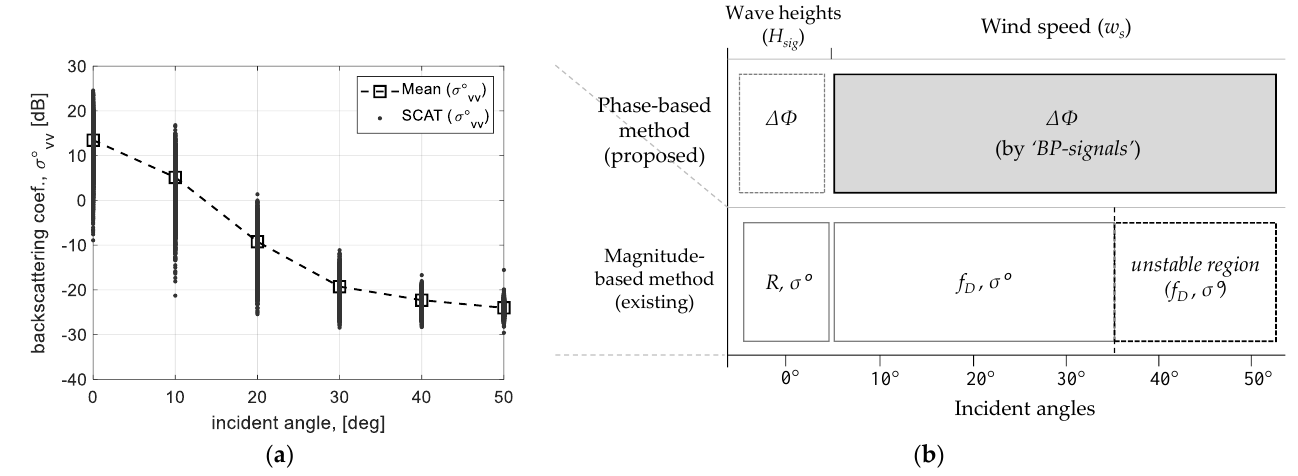
Figure 2. Radiometric angular responses from the sea surface and available range of radar measure- ment parameters: ( a ) backscattering coefficients ( σ ° vv ) measured by self-manufactured scatterometer [11], and ( b ) comparison of the operating range of the proposed and existing method.